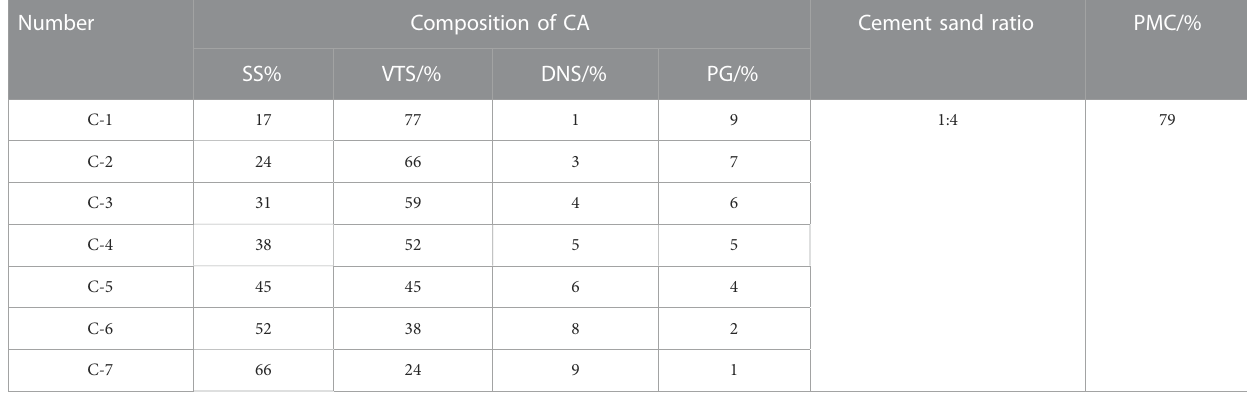
TABLE 3 Mix proportion of total-tailings CPBM.